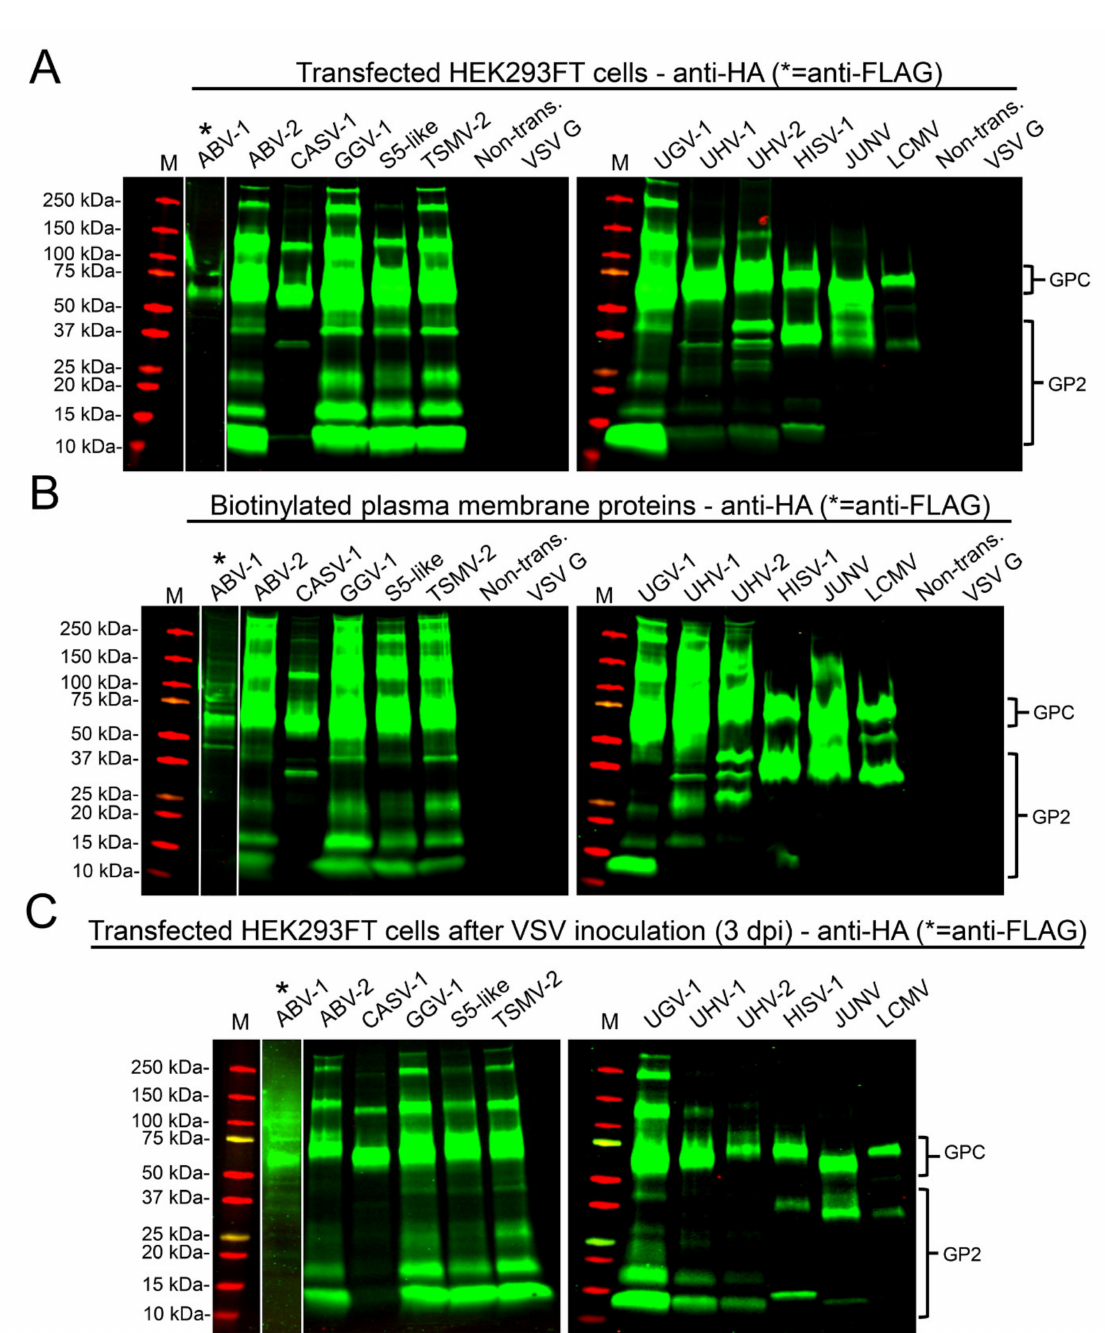
Figure 2. Immunoblots of transfected cells and concentrated VSV pseudotypes. ( A ) Expression of arenavirus GPCs in HEK293FT. The proteins separated on SDS-PAGE and transferred onto nitrocellulose were probed with an anti-HA antibody. ( B ) Anti-HA immunoblot of biotinylated plasma membrane proteins from cells transfected with arenavirus GPCs. ( C ) Anti-HA immunoblot of HEK293FT cells transfected with arenavirus GPCs at 3 days post VSV inoculation. In A to C, the intact GPCs migrate at approximately 60–75 kDa and the cleaved GP2s between 10 and 37 kDa, as indicated. Anti-FLAG antibody served for ABV-1 GPC detection from the same membrane, but due to di ff erences in the band intensity the anti-FLAG staining is shown as a strip overlaid on top of the anti-HA staining. M = molecular weight marker (Precision Plus Protein Dual Color Standards, Bio-Rad). Odyssey Infrared Imaging System (LI-COR) served to record the